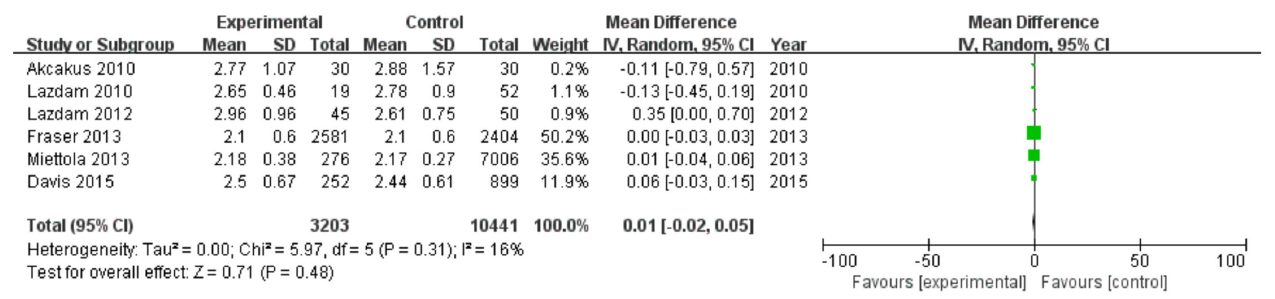
Figure 6. Meta ‐ analysis forest map for high ‐ density lipoprotein cholesterol of offspring of PE preg ‐ nancies. Lazdam 2010 [15]; Akcakus 2010 [14]; Lawlor 2011, [20]; Miettola 2013, [23]; Fraser 2013, [24]; Alsnes 2014, [25]; Davis 2015, [26]; Alsnes 2017, [28]. 3.2.6. Non ‐ HDL Cholesterol Among 16 included studies, 3 studies investigated non ‐ HDL cholesterol data of pa ‐ tients, including 400 patients in the experimental group and 26,498 in the control group, with data heterogeneity (I 2 = 93%) (Figure 7). The analysis showed that the non ‐ HDL cho ‐ lesterol value in the PE pregnancy offspring group presented an elevation relative to the non ‐ PE pregnancy offspring group [MD = 0.16, 95%CI (0.13, 0.19), p < 0.00001], with sta ‐ tistical significance (Figure 7).